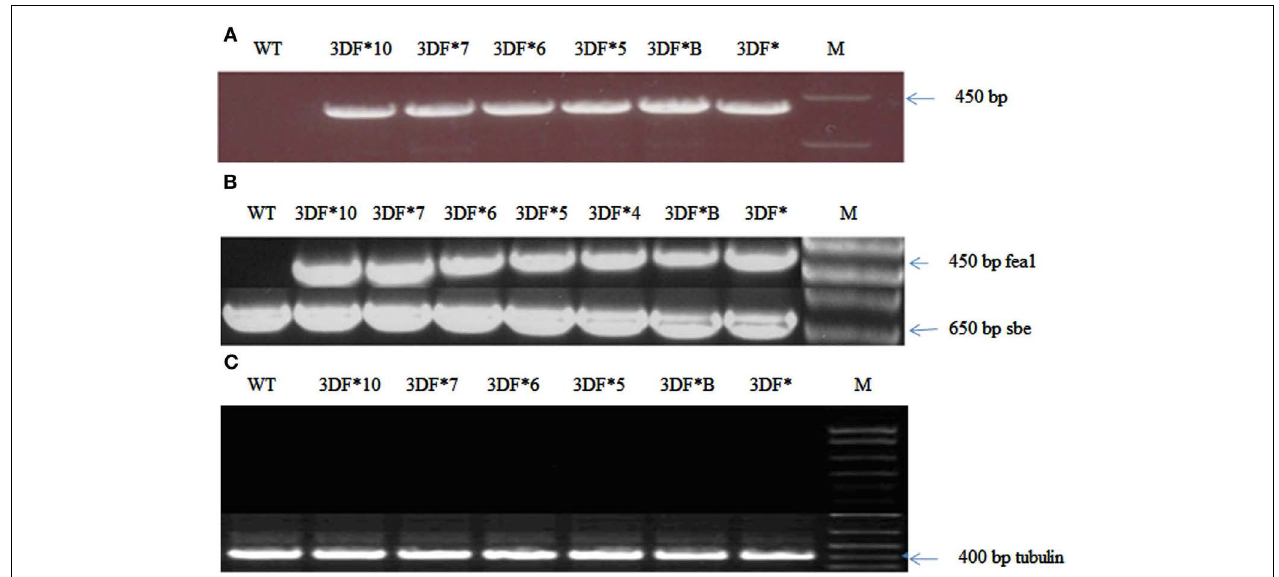
analysis of FEA1 gene expression in roots of transgenic and wild-type cassava plants.The cassava sbe1 gene was used as loading control. (C) RT-PCR analysis of FEA1 gene expression in leaves of transgenic and wild-type cassava plants. Loading control for (B) is cassava α -tubulin gene.